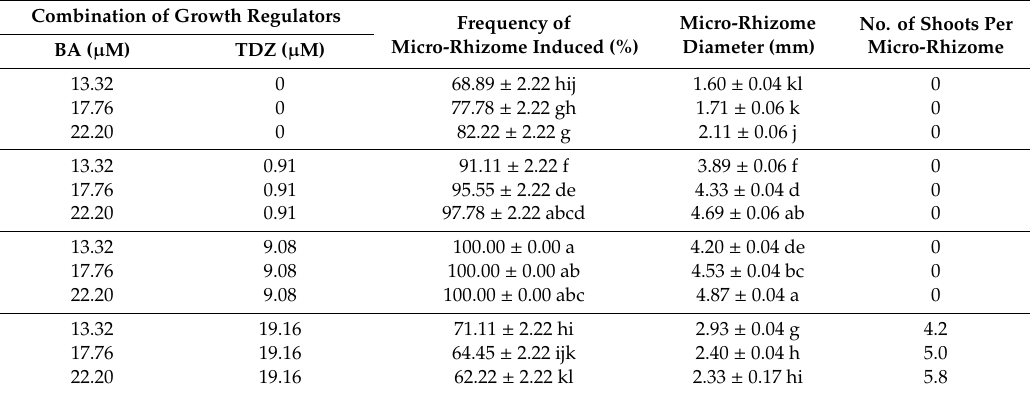
Table 2. Induction of micro-rhizomes from mature stem explants of H. coronarium ‘Hanyue’ after six weeks of culture on Murashige and Skoog medium supplemented with 0.05 µ M α -naphthaleneacetic acid (NAA) with di ff erent combinations of 6-benzylaminopurine (BA) and thidiazurin (TDZ). Combination of Growth Regulators